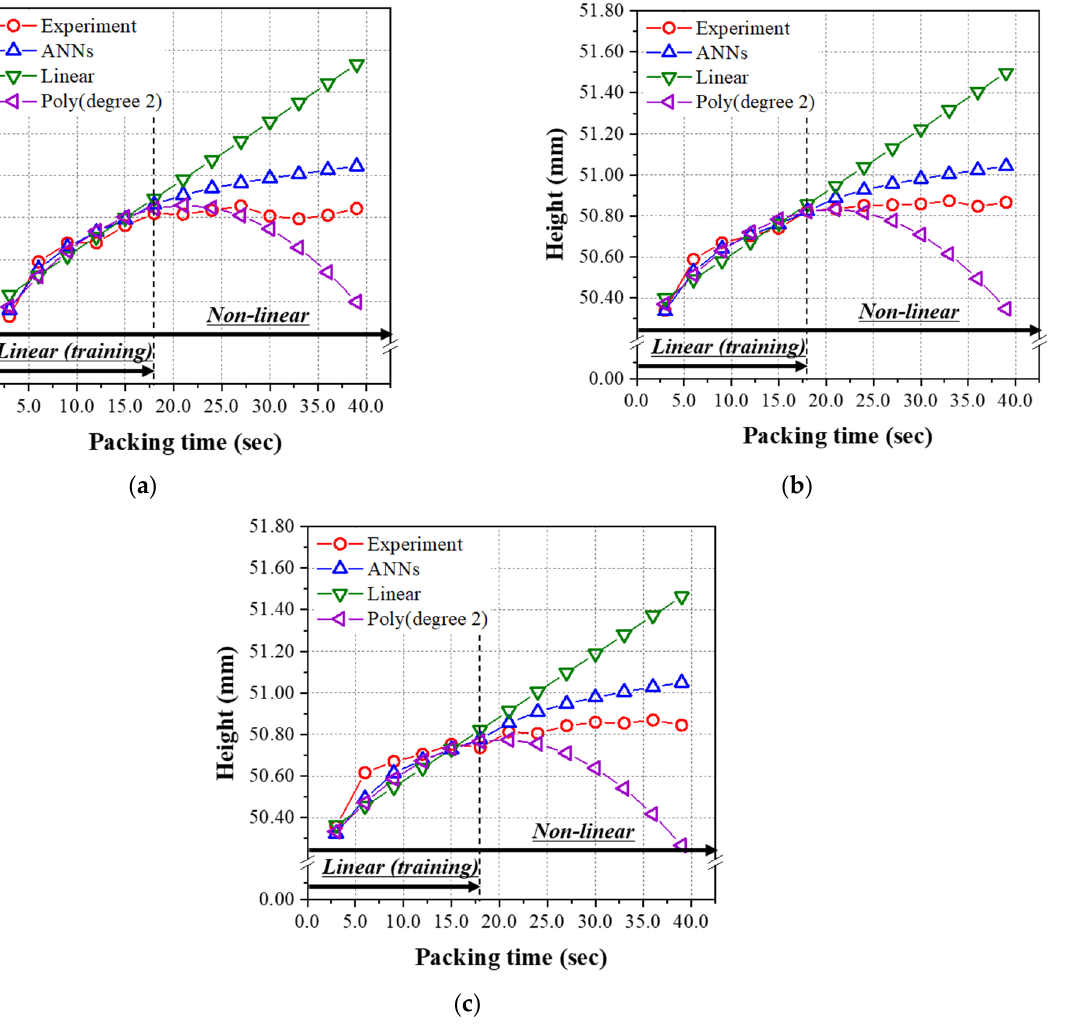
Figure 10. Predicted heights of the nonlinear relation group from Table A2 using the models learned by the linear relation group (packing time was 3.0~18.0 s). Melt temperatures; ( a ) 200 °C, ( b ) 220 °C, and ( c ) 240 °C.